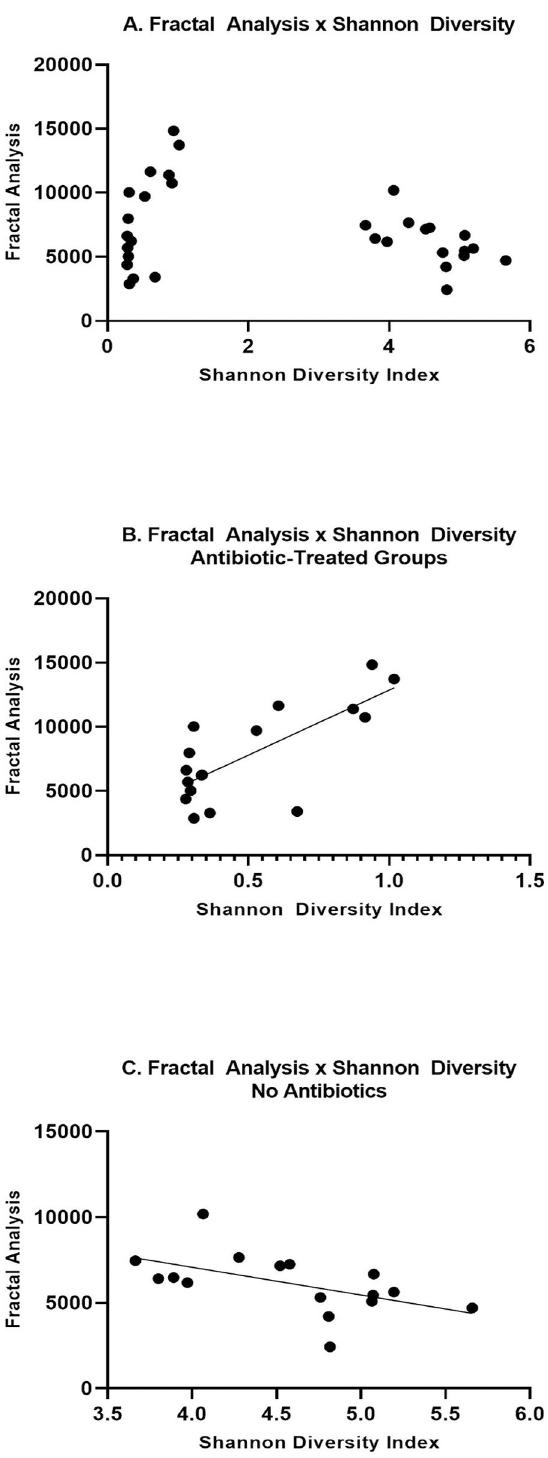
Fig 8. Correlations for fractal analysis and Shannon Diversity. (A) All groups are plotted, including results with low Shannon diversity for antibiotic-treated vs. higher Shannon diversity for mice that received normal drinking water. (B) A positive correlation (Spearman r = 0.5637; p = 0.0203) was determined for antibiotic-treated mice. (C) A negative correlation (Spearman r = -0.5735; p = 0.0223) was determined for normal drinking water mice.